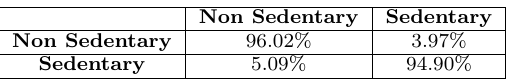
Table 1: Sedentary, Non sedentary confusion matrix